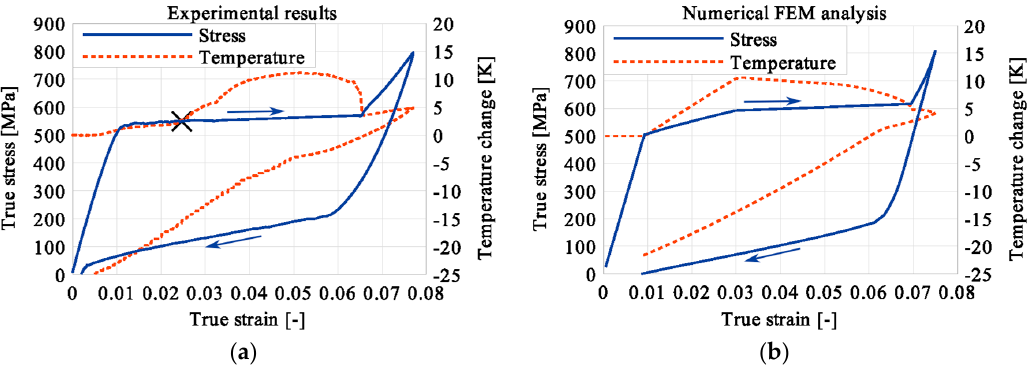
Figure 8. Stress and temperature variations vs. strain for the loading program (2): 3-min loading interruption in the middle of the LMT: ( a ) experimental; ( b ) numerical results.